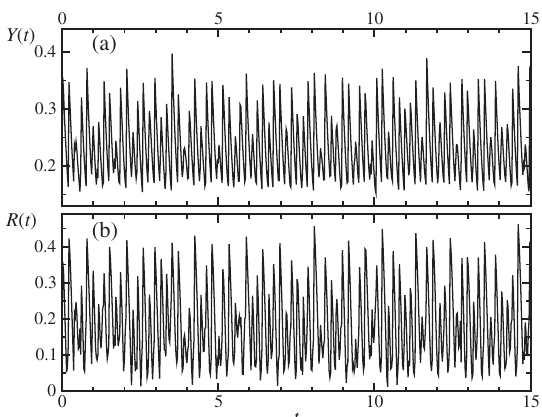
FIG. 5. Time evaluation of Y (a) and R (b) for g ¼ 1 . 3 and system sizes N ¼ 4000 .